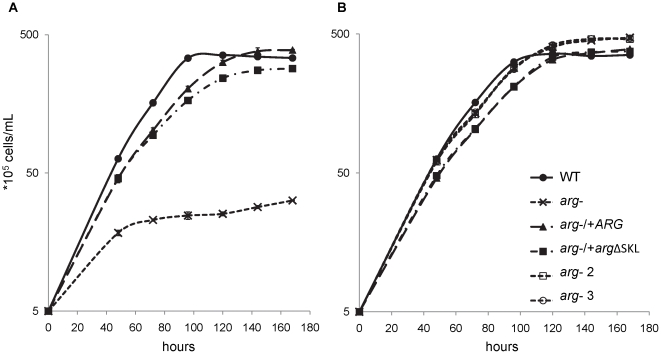
ARG absence impairs parasite growth in vitro.Growth curves of L. amazonensis wild type (WT), ARG knockout (arg
−) and the add-backs arg
−/+ARG and arg
−/+argΔSKL promastigotes in the absence (A) or presence (B) of 10 µM (arg
− 2), 30 µM (arg
− 3) or 50 µM (WT, arg
−, arg
−/+ARG and arg
−/+argΔSKL) putrescine. The obtained values are the means (+/− SD) of one representative experiment performed in triplicate.